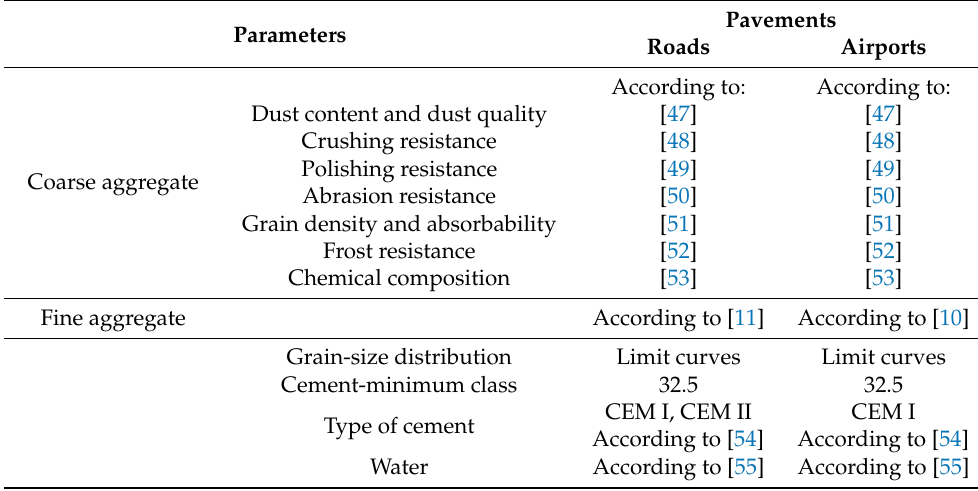
Table 1. Material requirements for the composition of concrete intended for road and airport pavements—surface layer